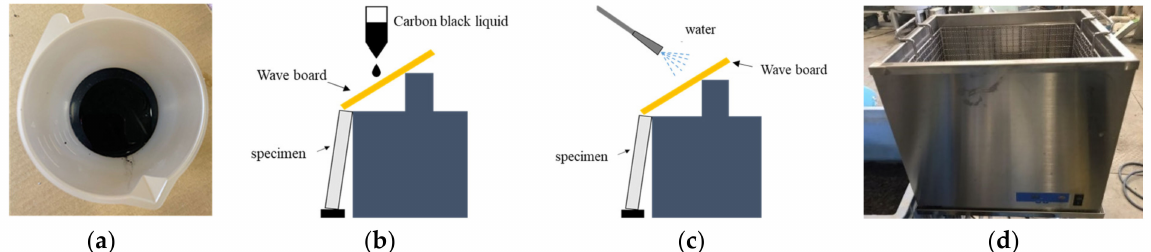
Figure 1. The carbon black liquid dropping method ( a ); carbon black liquid ( b ); the spray cleaning method ( c ); ultrasonic cleaning machine ( d